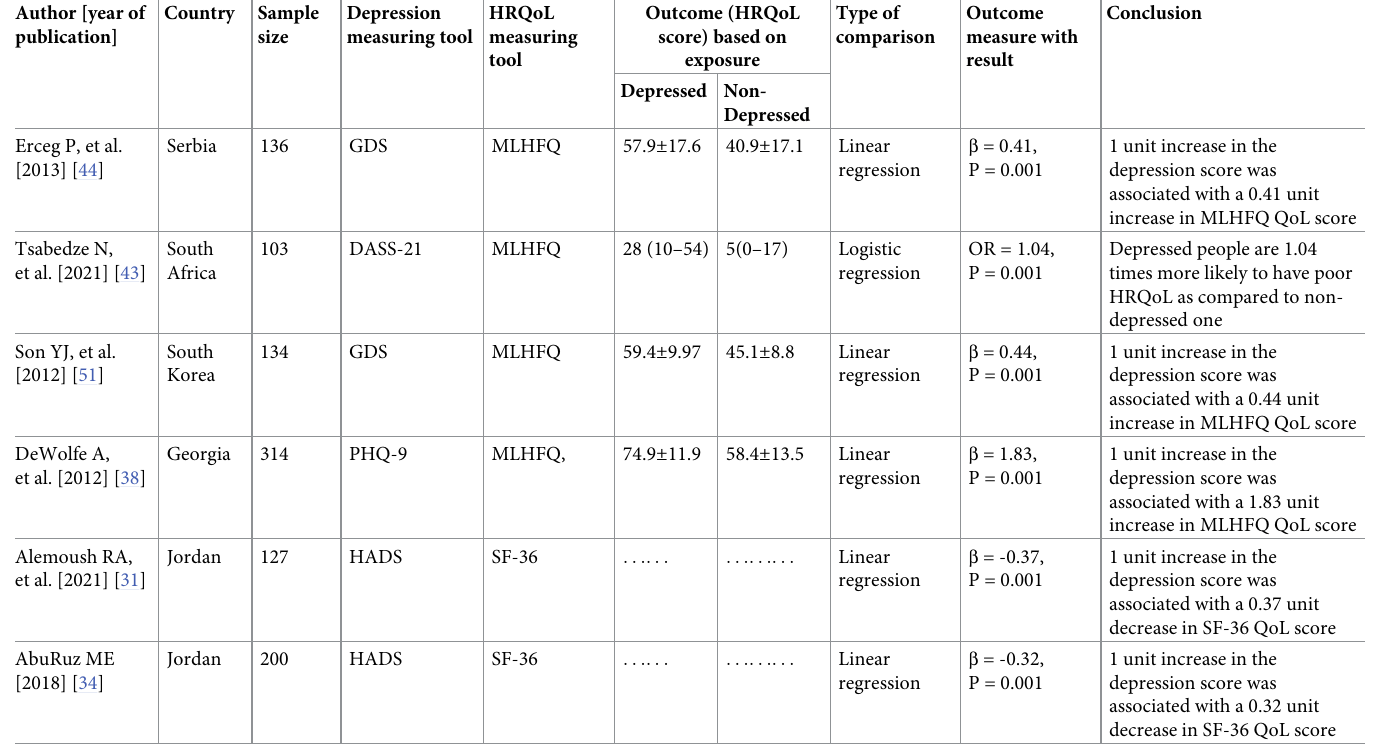
Table 6. The association between depression and health-related quality of life in people with heart